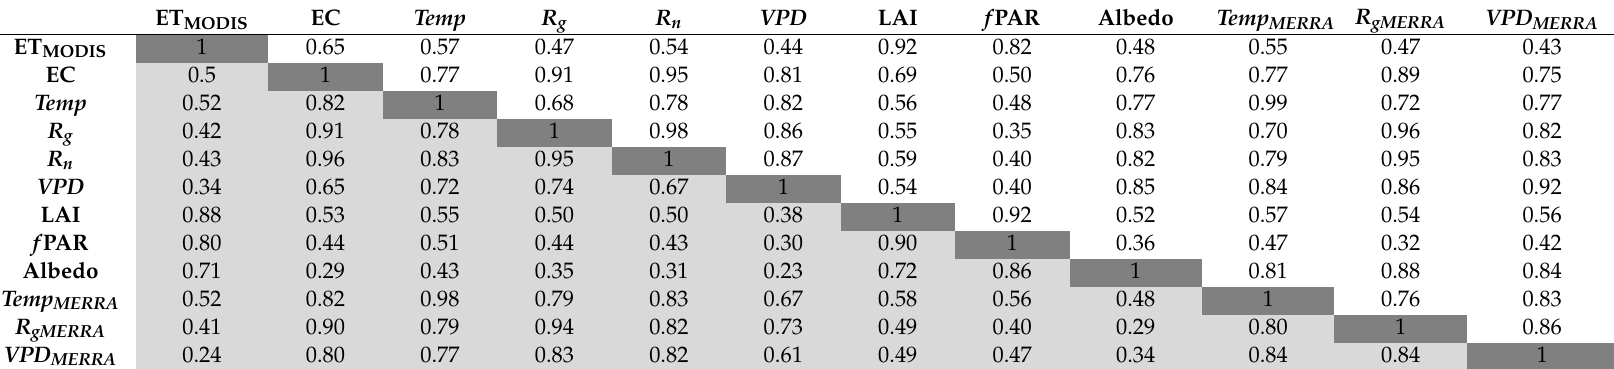
f PAR 0.80 0.44 0.51 Albedo 0.71 0.29 0.84 Temp MERRA 0.52 0.82 0.98 0.79 0.83 R gMERRA VPD MERRA